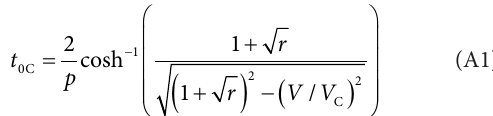
FigUre a1 | Verification of critical timing: plot of θ 2max / α with respect to t 0 / t 0C